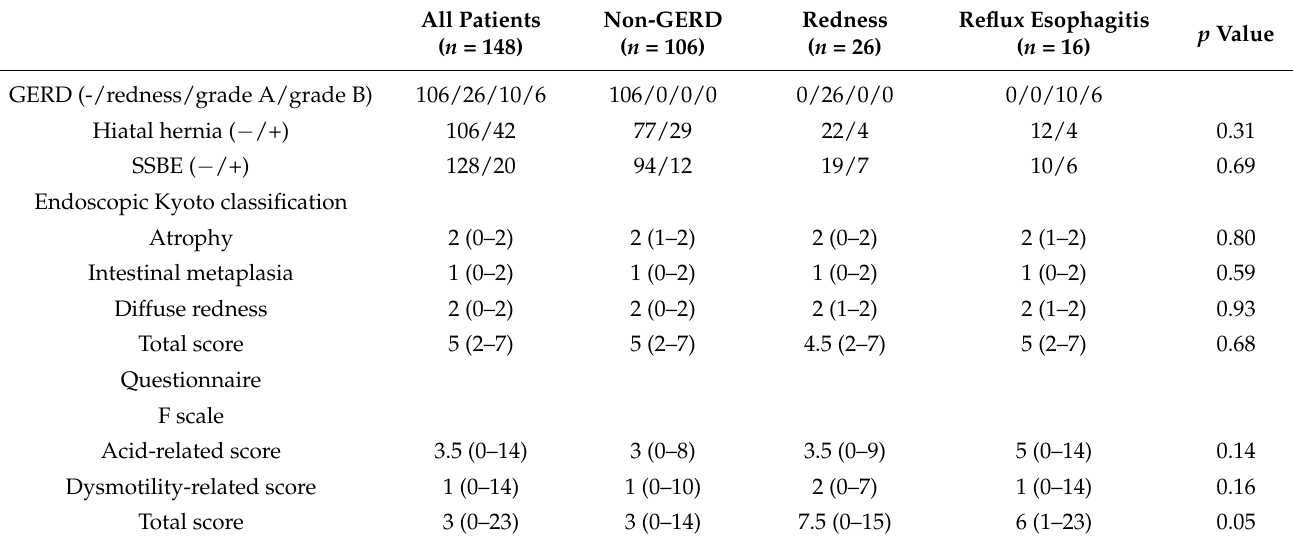
Table 2. Characteristics of patients at 12 months after eradication success.